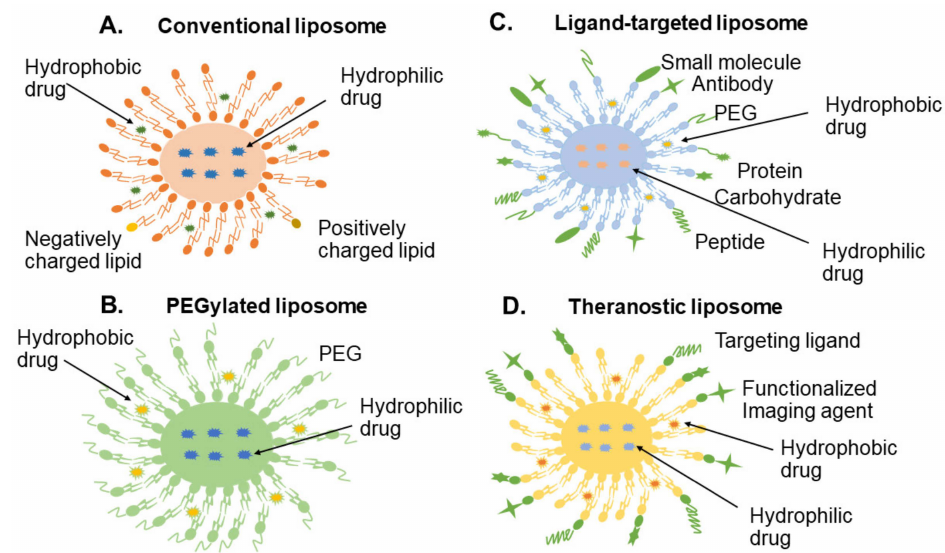
Figure 2. Schematic illustration of different types of liposomal drug delivery systems: ( A ) Conven- tional liposome, ( B ) PEGylated liposome, ( C ) Ligand-targeted liposome, ( D ) Theranostic liposome (adapted from Sercombe, L., et al. Frontiers in Pharmacology , 2015 [54]).